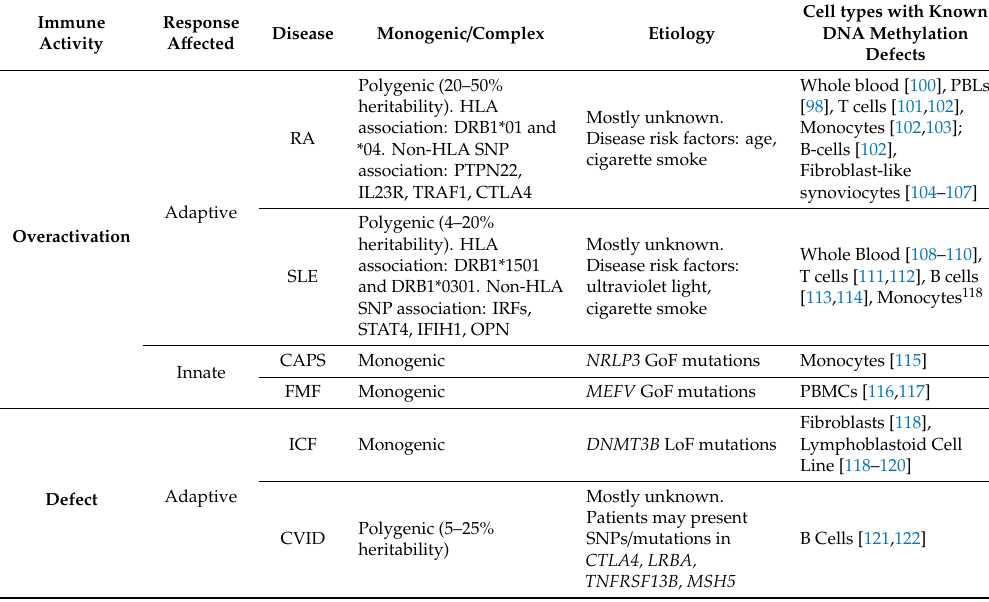
Figure 3. Classification recommendation of immune system diseases: This graph depicts a proposed methodology for the classification of immune diseases, accounting for type of response affected (innate/adaptive) and effect of the dysfunction in activity (underactivation/overactivation). Each quadrant discriminates cases of diseases with diverse implications regarding the two axes. Dot color indicates the number of genes affected in each disease: red for monogenic diseases, yellow for polygenic diseases. Dashed points: examples of diseases not further detailed in the text. CVID: Common variable immunodeficiency, TLR: Toll-like receptor; ICF: Immunodeficiency-centromeric instability-facial anomalies; MSMD: Mendelian susceptibilities to mycobacterial disease; FMF: Familial Mediterranean Fever; CAPS: Cryopyrin-associated periodic syndromes; SLE: Systemic Lupus Erythematosus; RA: Rheumatoid arthritis. Table 1. Selected examples of DNA methylation implications in immune disease.